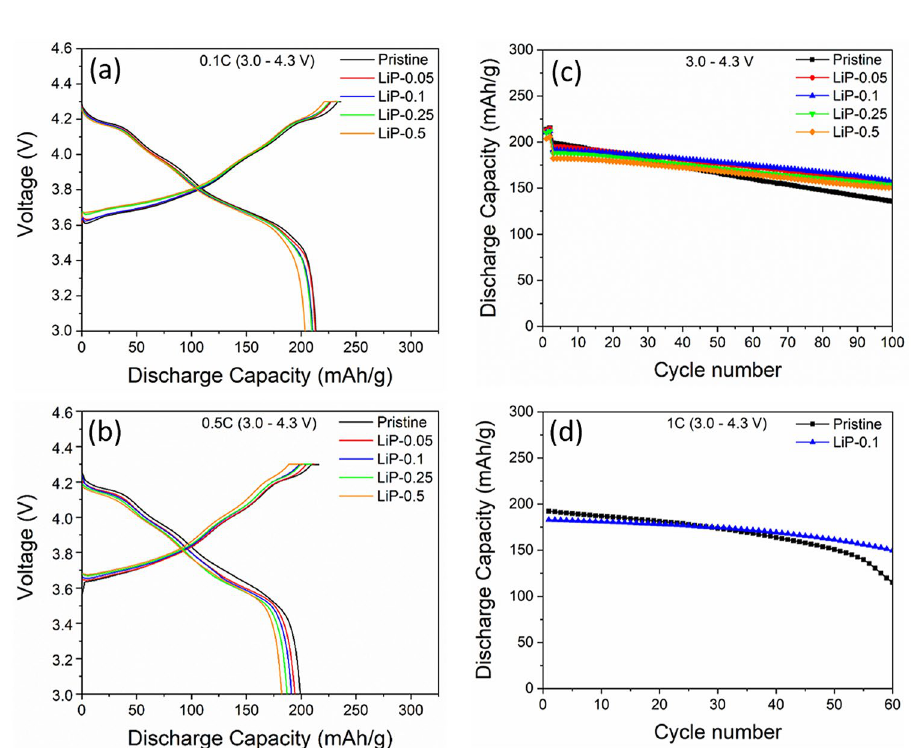
Figure 5. The initial charge–discharge curves of samples at ( a ) 0.1C, ( b ) 0.5C, ( c ) Cycle performance at 4.3 V and ( d ) Cycling performance of pristine and LiP-0.1 at 1C